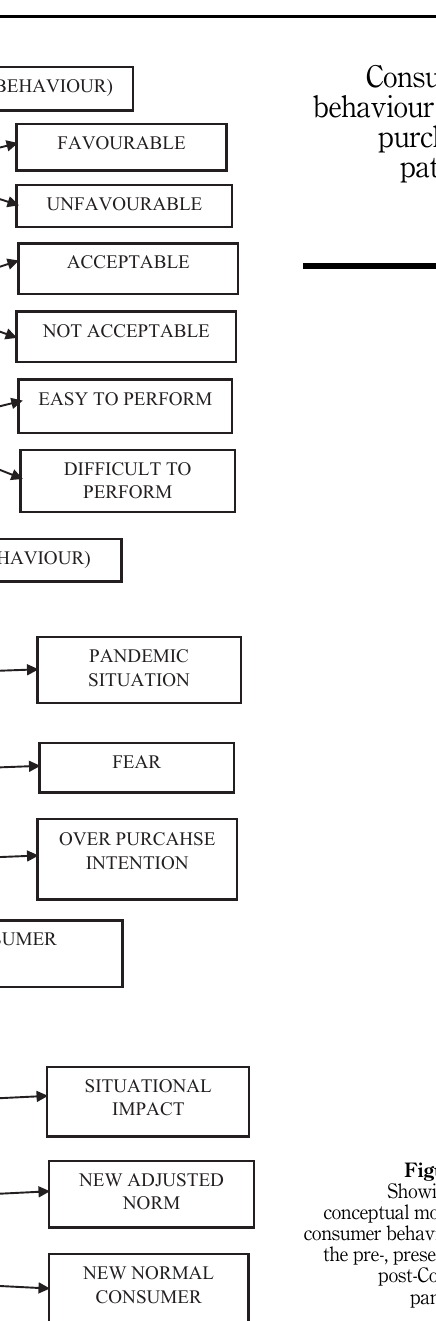
Figure 1. Showing